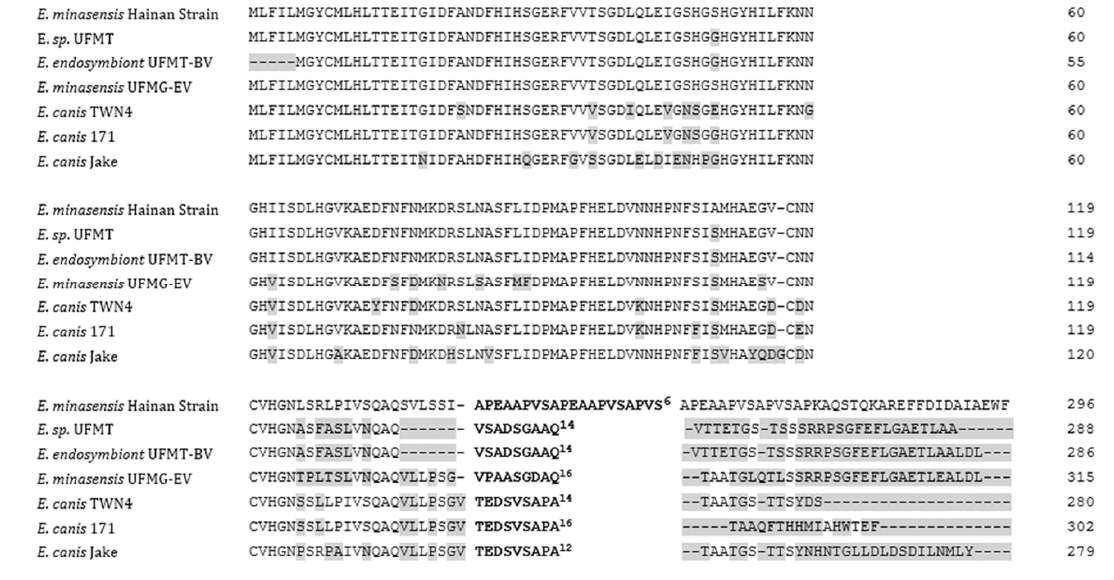
Figure 2. Comparison of the trp36 amino acid sequences from the Hainan strain and other strains of Ehrlichia minasensis (strains UFMT, UFMT-BV, and UFMG-EV) and strains of Ehrlichia canis (strains TWN4 and Jake). Amino acids highlighted in grey represent residues divergent from the Ehrlichia minasensis Hainan Strain sequence. The superscripted numbers correspond to the number of tandem repeats of the 9-20 residue unit.